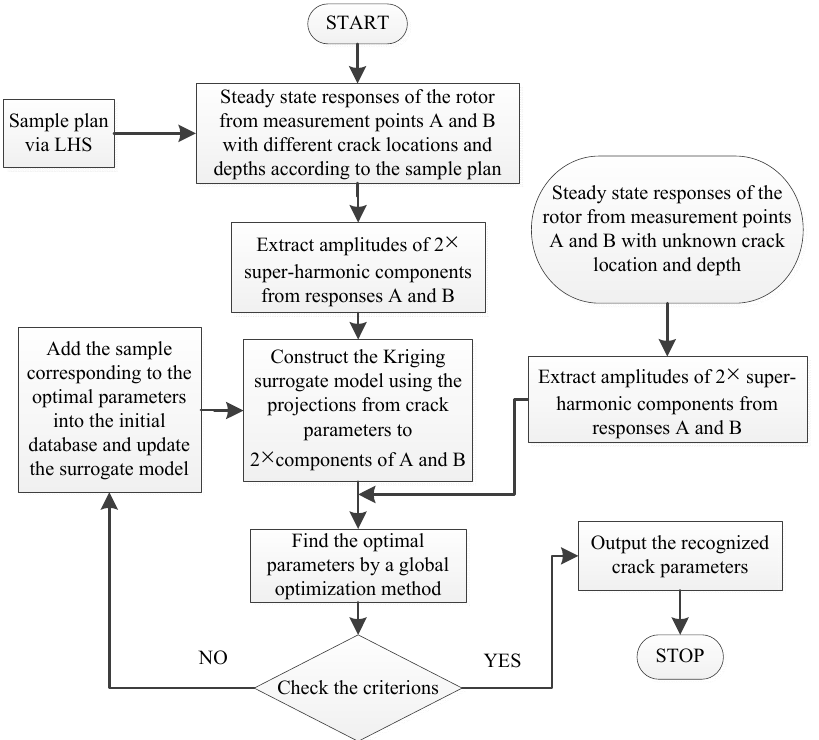
Figure 6. Flowchart of the crack identification method.